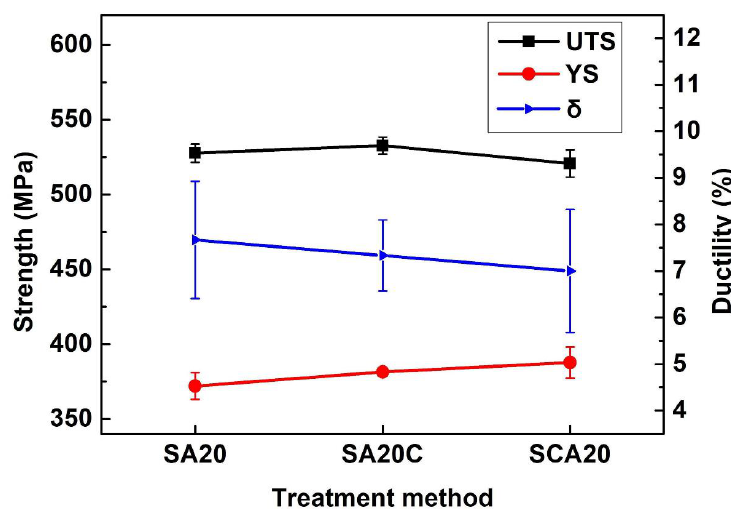
Figure 6. Tensile properties of specimens treated by different processes.